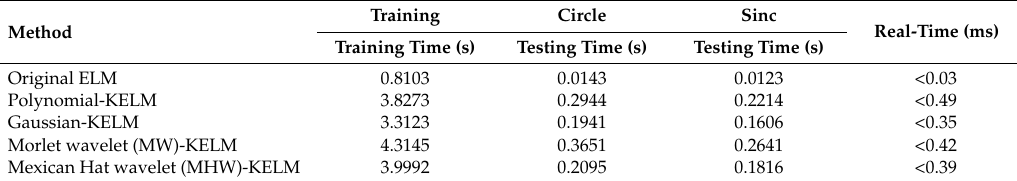
Table 4. Calculating